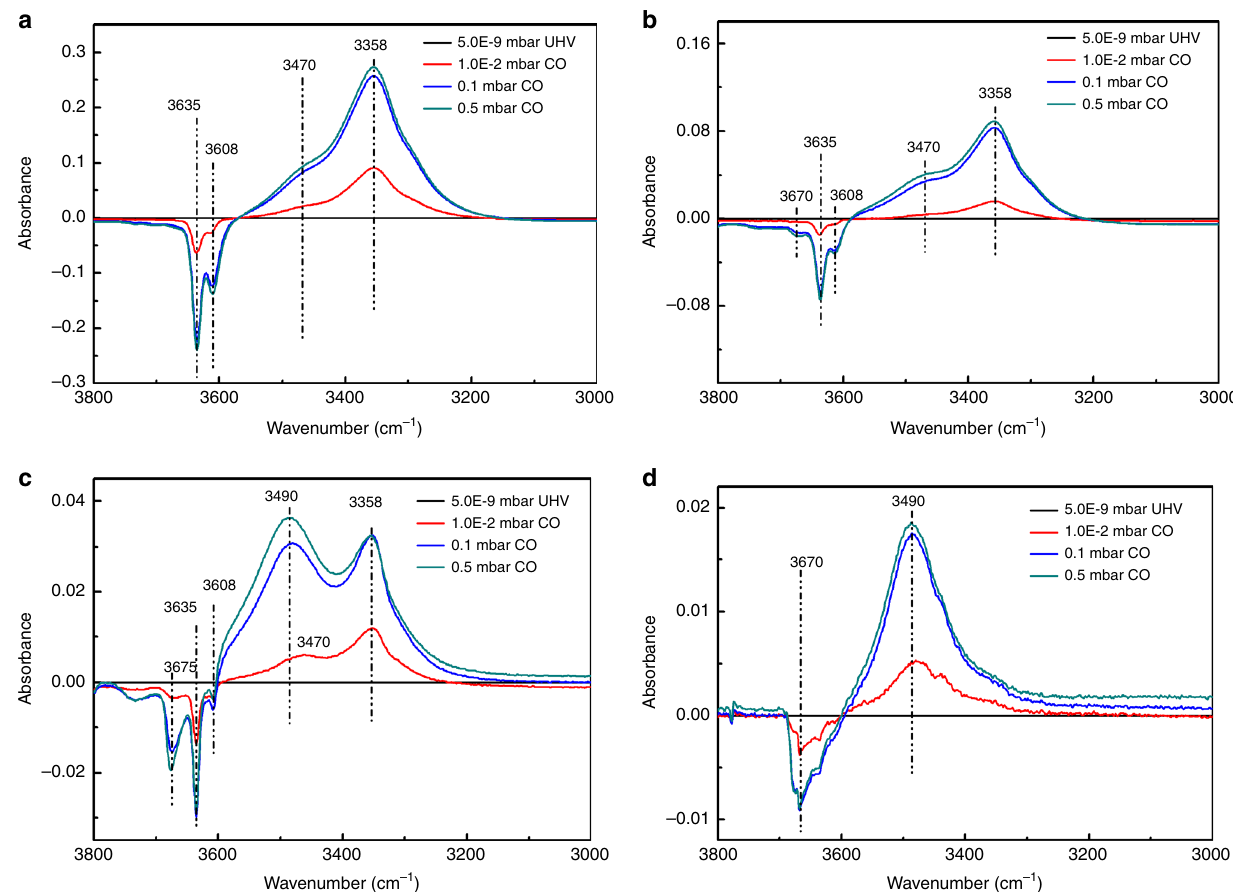
Fig. 5 In situ FTIR spectra of CO adsorption. a SAPO-34; b low-Si AlPO-34; c low-Si AlPO-18; and d AlPO-18 (UHV: ultra-high vacuum)